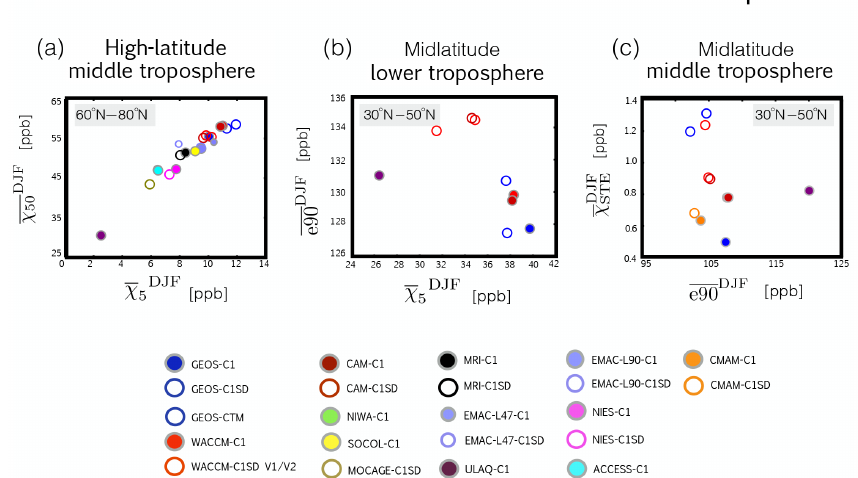
Figure 4. (a) Correlations of 400–700hPa averages of χ DJF DJF χ DJF and e90 averaged over 700–900hPa and over the midlatitude source region. (c) Same as panel (b) , except for χ DJF 5 over 400–700hPa. The different colors correspond to the different simulations, with open circles denoting REF-C1SD simulations and closed circles corresponding to REF-C1 (grey outline). Circles denote the climatological boreal winter mean over 2000–2009.